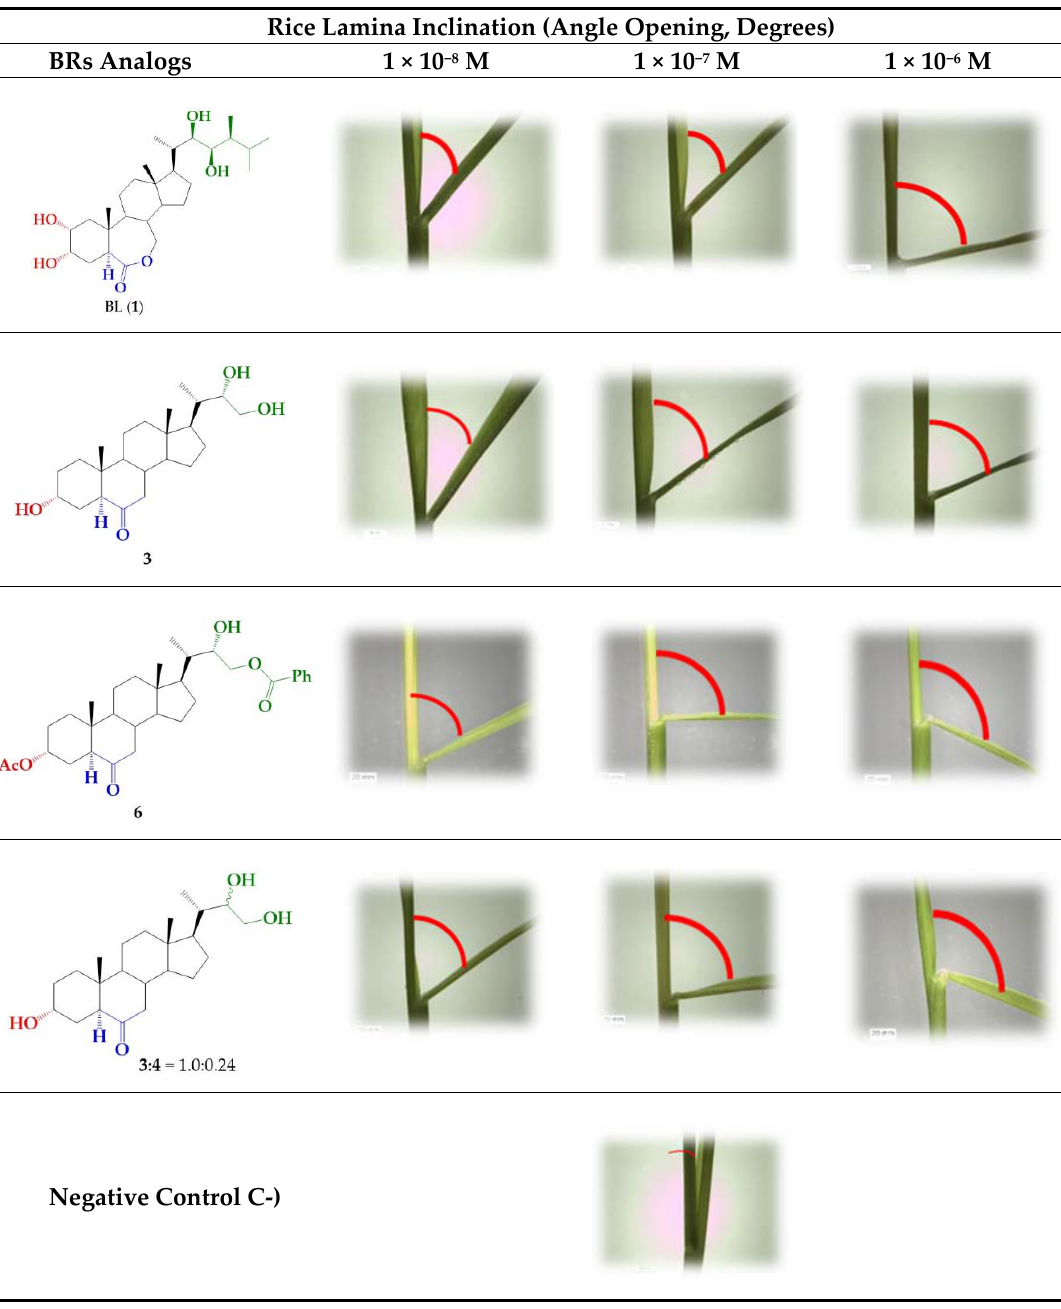
Table 1. Effect of BR 24 ‐ norcholane type analogs and epimeric mixtures of 3/4 on lamina inclination of rice seedlings. Brassinolide was used as positive control.